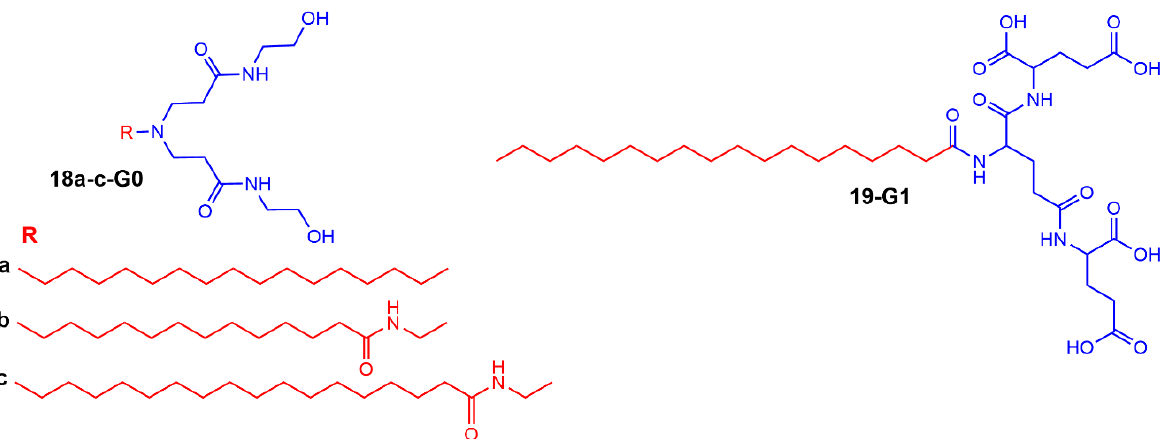
Figure 14. Amphiphilic dendrons having a long alkyl chain as their core.